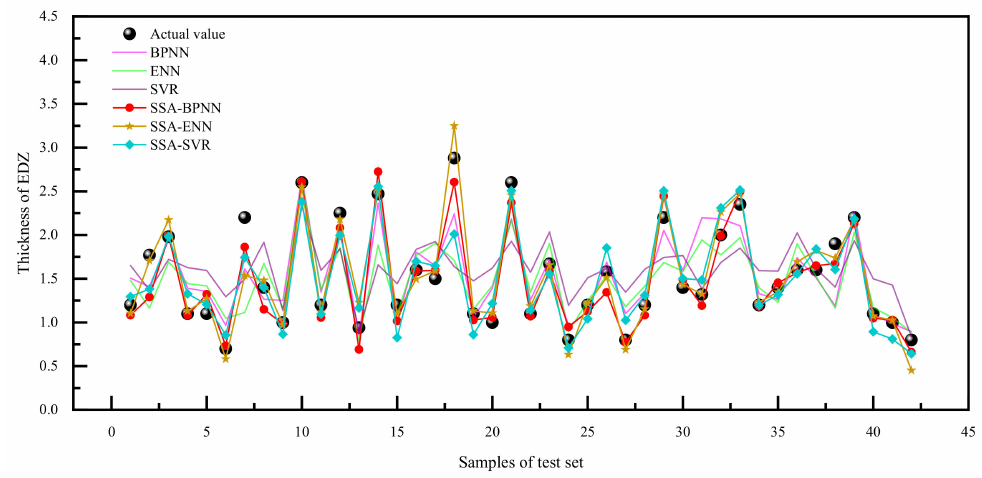
Figure 20. Predicted and actual values of each